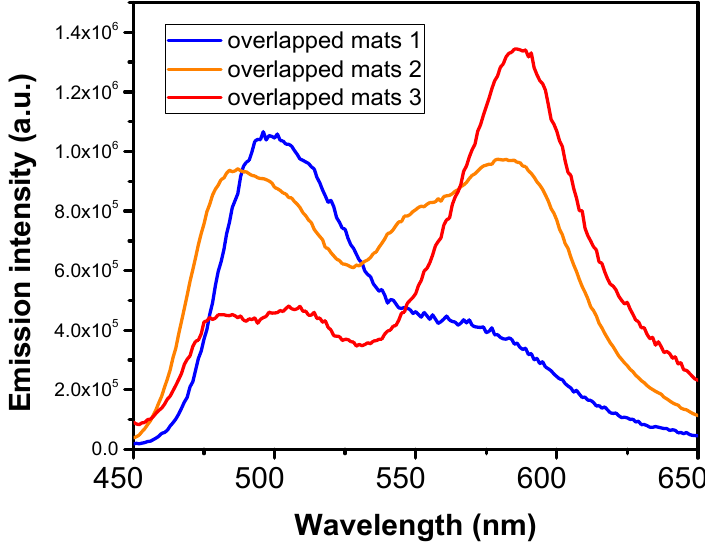
Figure 7. Photoluminescence (PL) spectra of overlapping mats of coumarin 6, rhodamine 6G, and sulforhodamine 101 doped fibers with different thicknesses.